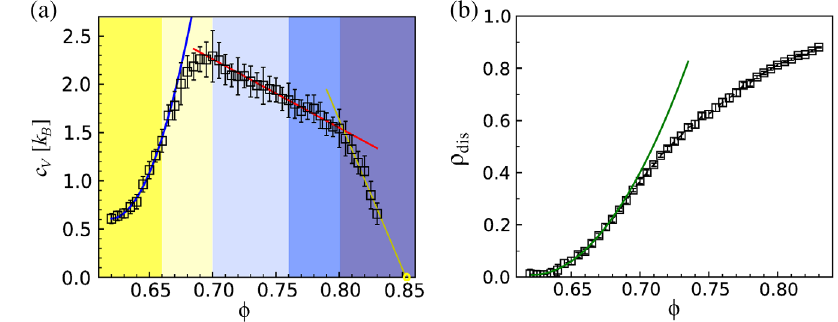
515 . 6 ð ϕ − 0 . 6197 Þ 2 þ 0 . 608 ] in the polycrystal regime and with a quadratic fit [blue curve, c V V ¼ ϕ ¼ 0 . 853 Þ ¼ 0 marked by the yellow V ð 62 . 95 ð ϕ − 0 . 621 Þ 2 þ 0 . 0081 (green curve) in the polycrystal dis ¼ ∝ ρ V dis